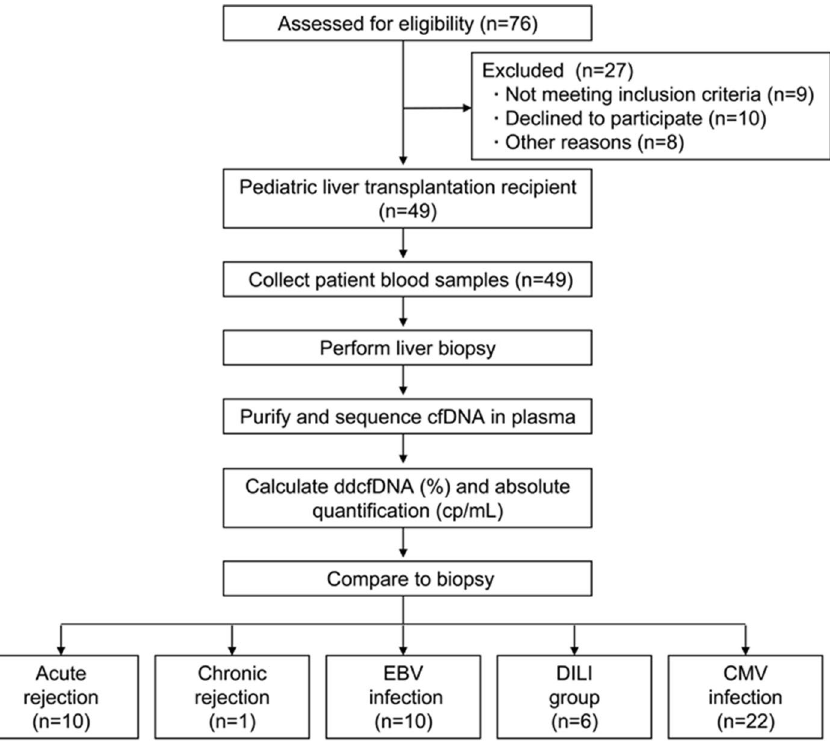
Figure 1. Enrollment of patients, collection of clinical samples, analysis workflow and subgroups information. Pediatric recipients with ESLD listed for liver transplantation at Renji Hospital were enrolled. Multi-organ transplant recipients were excluded. From May to September in 2019, a total of 76 pediatric patients receiving a liver graft were enrolled and there were 27 patients excluded as described in Suppl Table 1. Ultimately plasma samples and matched liver specimens from 49 patients were successfully studied. All the samples were collected whenever rejection was suspected clinically. In each case, blood samples were collected 2 h before biopsy procedures being performed. Data on the fraction of dd-cfDNA (dd-cfDNA%) and absolute number of dd-cfDNA copies per mL of plasma were compared to liver biopsy results.